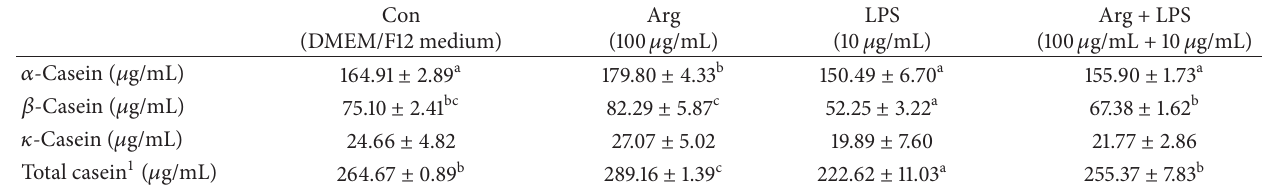
Table 3: Effects of arginine on casein synthesis in LPS-treated BMECs.